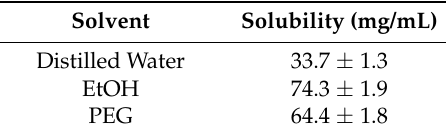
Table 1. Solubility values of DNa investigated in various